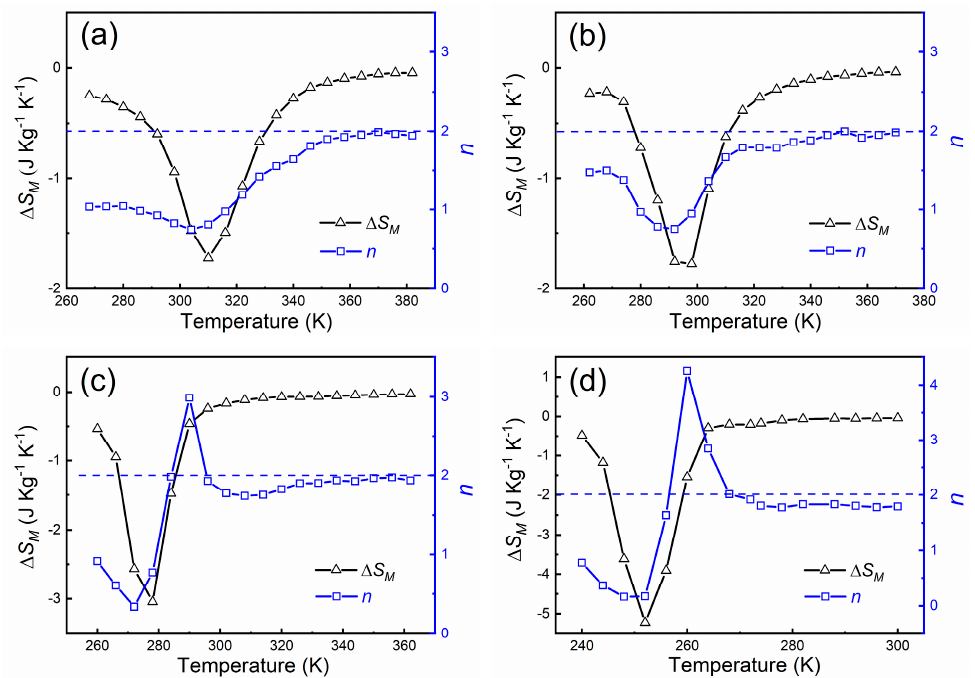
Figure 6. Temperature dependence of Δ S M and exponent n at the field of 1.5 T for the Hf 1- x Ta x Fe 2 alloys. ( a ) Hf 0.87 Ta 0.13 Fe 2 ; ( b ) Hf 0.86 Ta 0.14 Fe 2 ; ( c ) Hf 0.85 Ta 0.15 Fe 2 ; ( d ) Hf 0.84 Ta 0.16 Fe 2 . Adiabatic temperature change ( Δ T ad ), as an important performance index of MCE,